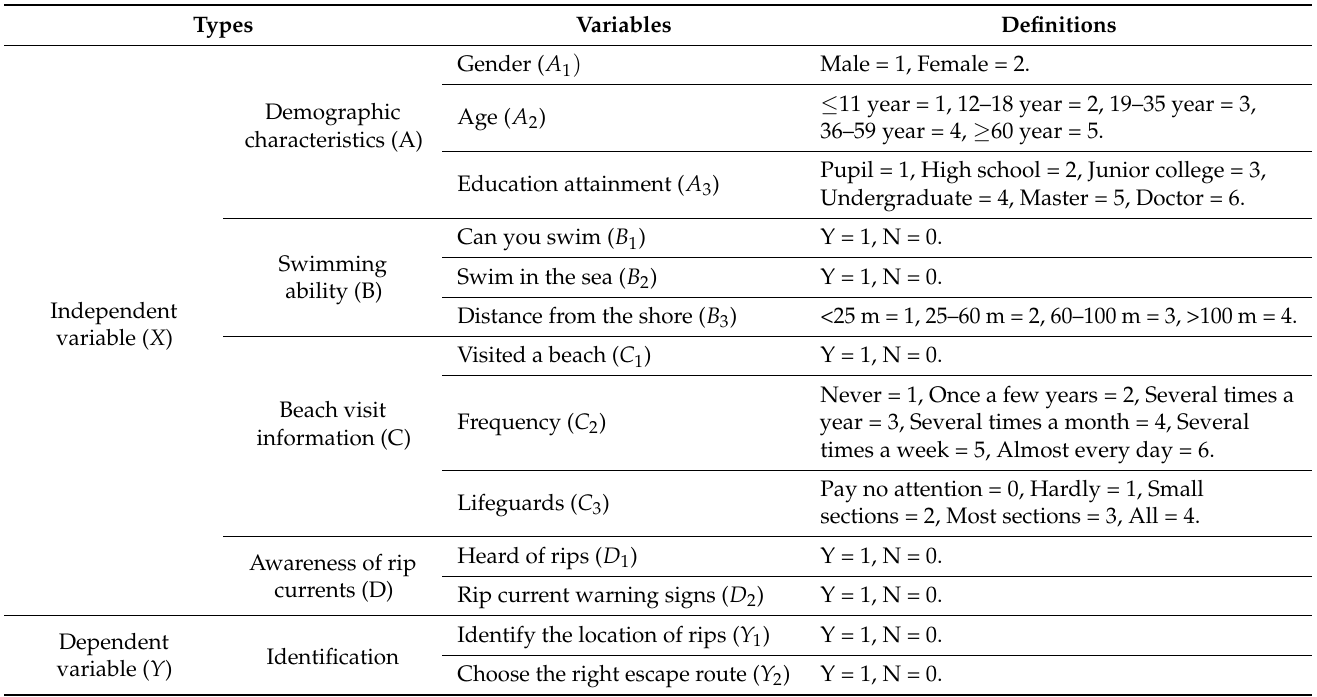
Table 3. Variable types and definition descriptions in the